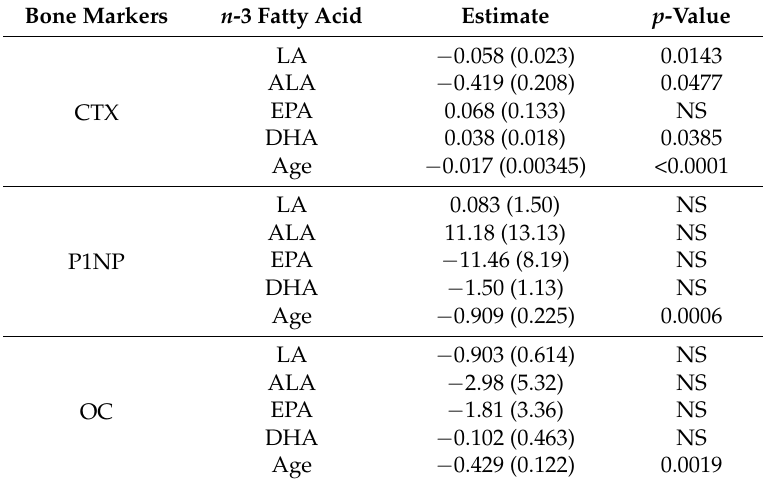
Table 2. Association between bone markers with individual n- 3 fatty acids and age 1 . Bone Markers